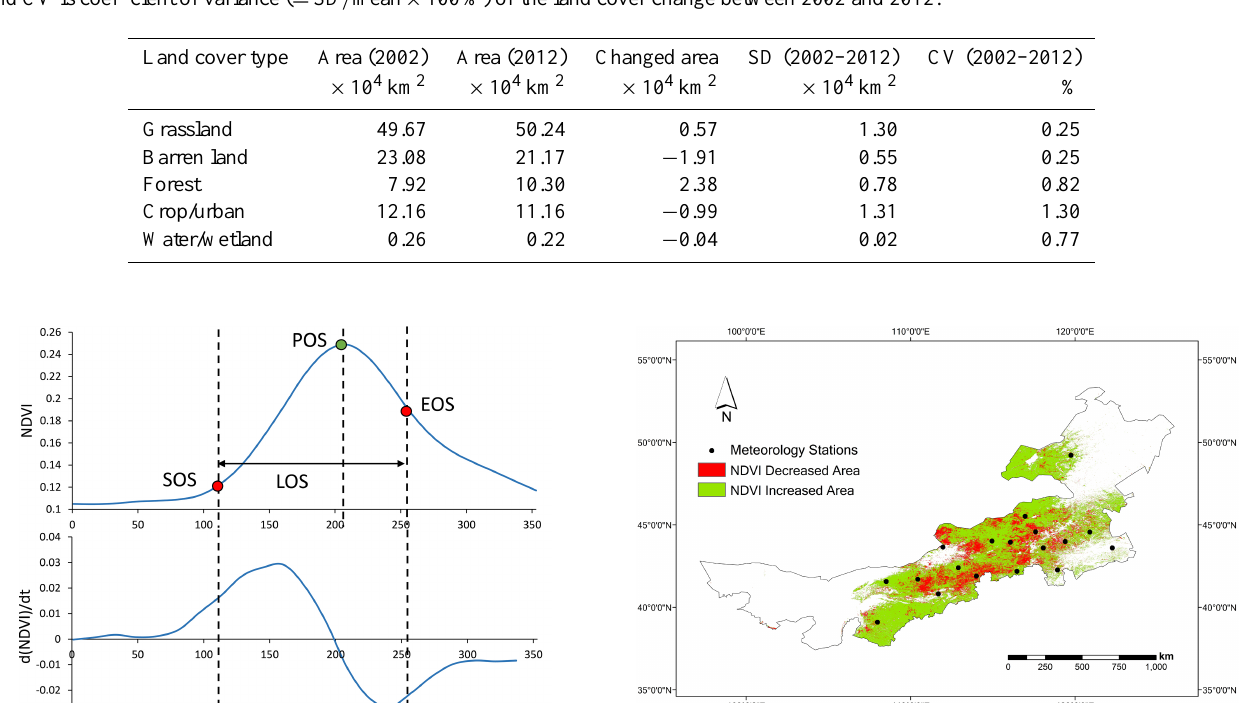
Table 2. Land cover changes in the Inner Mongolia Autonomous Region (2002–2012). The area unit is × 10 4 km 2 ; SD is standard deviation and CV is coefficient of variance ( = SD / mean × 100%) of the land cover change between 2002 and 2012.